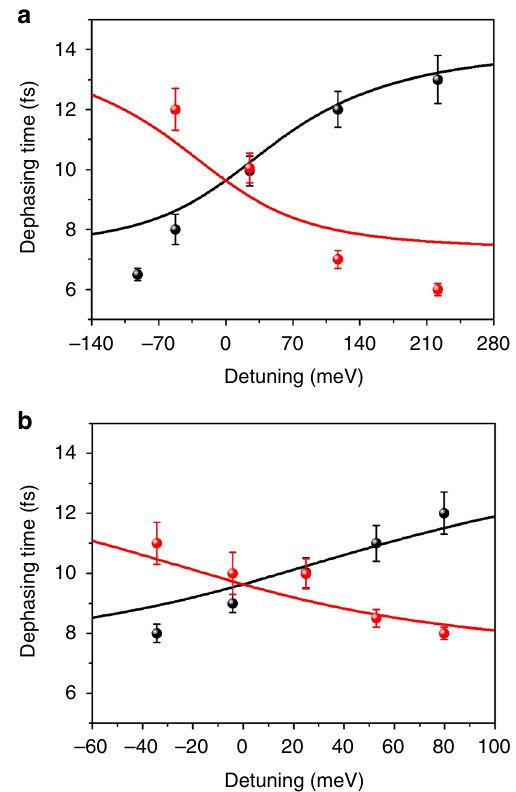
Fig. 6 Evolution of the dephasing time against the detuning. a Solid lines present the dephasing time extracted from the far- fi eld line width in Supplementary Fig. 9a. The scattered dots are the dephasing time measured by photoemission electron microscopy (PEEM) corresponding to results in Fig. 5. b Solid lines present the dephasing time extracted from the far- fi eld line width in Supplementary Fig. 9b. The scattered dots are the dephasing time measured by PEEM corresponding to the results shown in Supplementary Fig. 8. The red and black colors are used to distinguish the different branches. The error bars are the s.d. estimated by the maximum difference of several fi tted